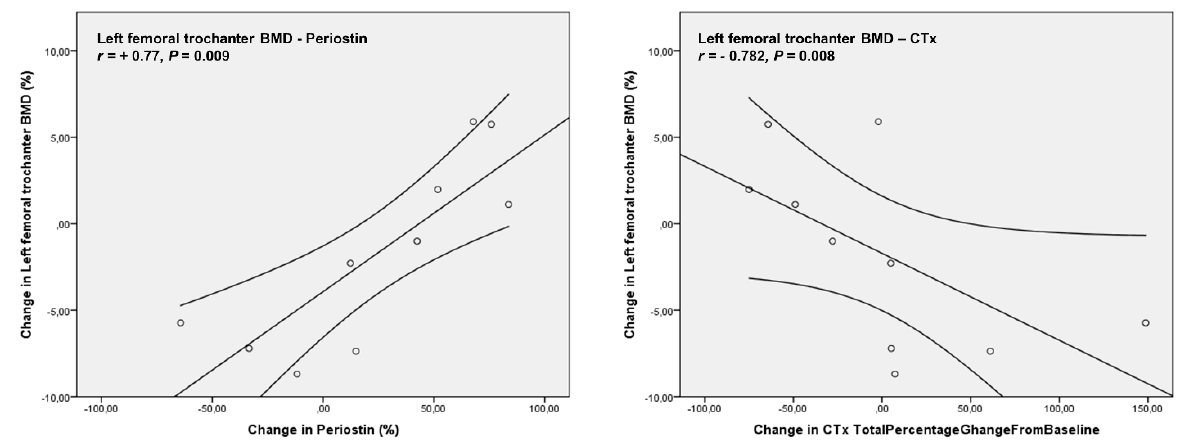
Figure 4. Percentage changes from baseline to 24 months in left femoral trochanter BMD were positively correlated with the percentage changes of Periostin and negatively with CTx levels.